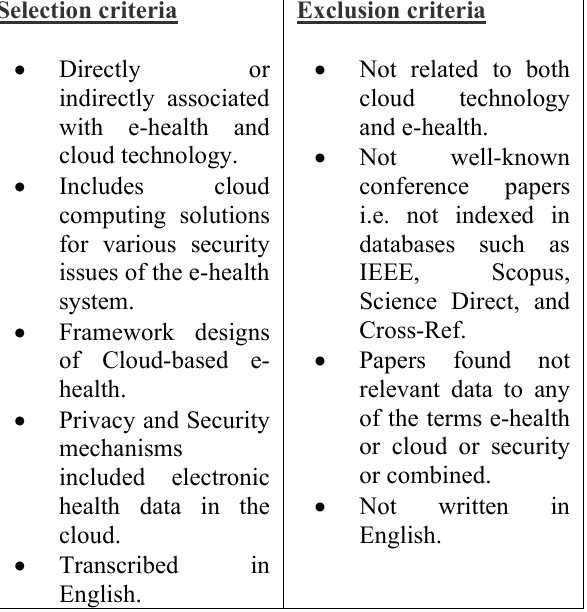
Table (1). Selection and Exclusion criteria to include papers in the review.